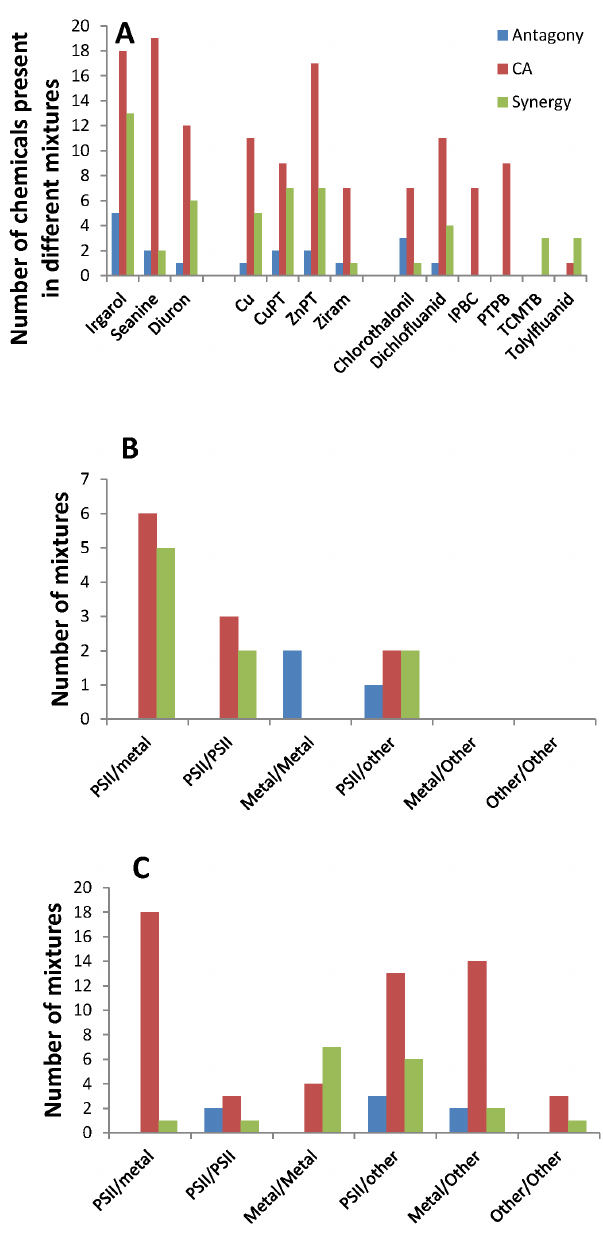
Figure 4. Frequency of antifoulant antagony, additivity and synergy. Figure 3A shows the number of times each of the antifoulants occur in a binary mixture resulting in antagony (blue bars), concentration additivity (CA) (red bars) or synergy (green bars). Antifoulants occurring in less than 1% of the mixtures were excluded. In figure B and C, the number of binary combinations of photosystem II herbicides (PSII) metal ions or metal containing compounds (Metal) and other organic compounds (Other) resulting in either antagony, concentration additivity or synergy are shown for mixtures tested on B) auto-tropic organisms (plants and algae, n =23) or C) heterotrophic organisms (microorganisms and animals, n =80).